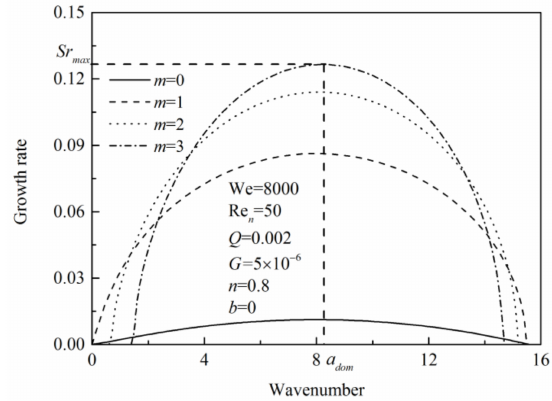
Figure 2. Instability curves of liquid cylindrical jet.